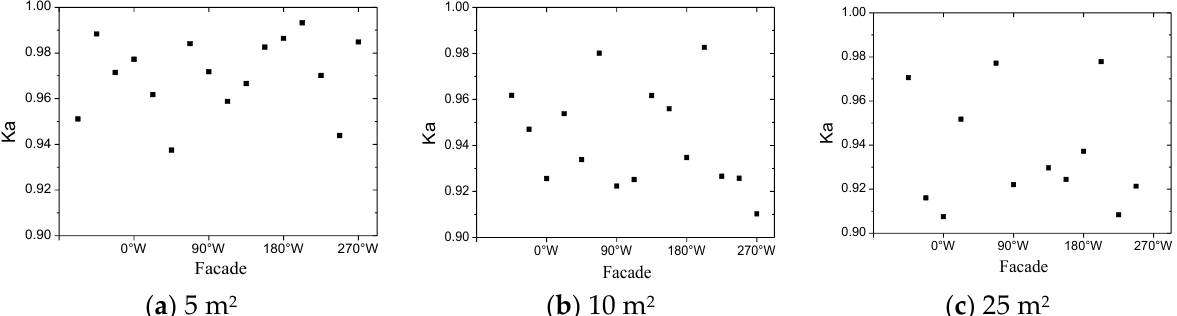
Figure 13. Reduction factors of block extremums of different areas under different wind directions: ( a ) 5 m 2 , ( b ) 10 m 2 , ( c ) 25 m 2 .